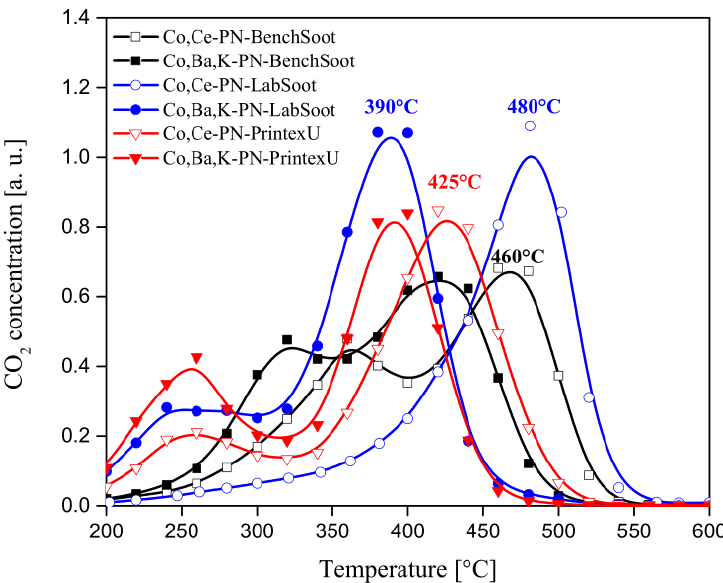
Figure 9. Activity of catalytic ceramic papers (Co,Ce and Co,Ba,K) for the combustion of different types of soot particles. Reactor inlet composition: 0.1% NO + 18% O 2 balance in He. Table 6. Catalytic combustion of soot: comparison of the activity of ceramic papers (PN) and catalytic ceramic